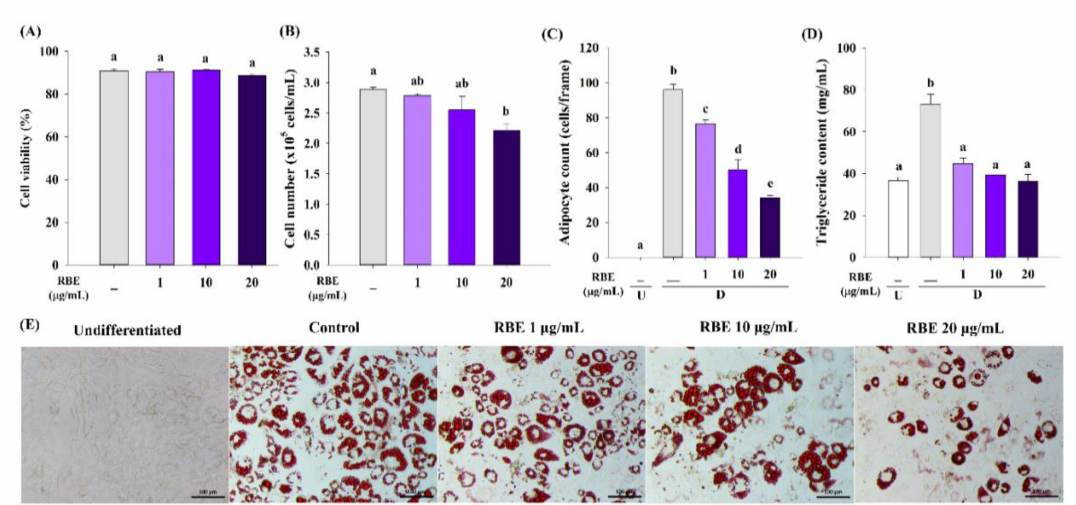
Figure 4. E ff ect of Riceberry rice extract (RBE) on adipogenesis in 3T3-L1 cells during an 8-day period. ( A ) Treatment of cells with RBE did not a ff ect cell viability during adipogenesis. ( B ) RBE at 20 µ g /